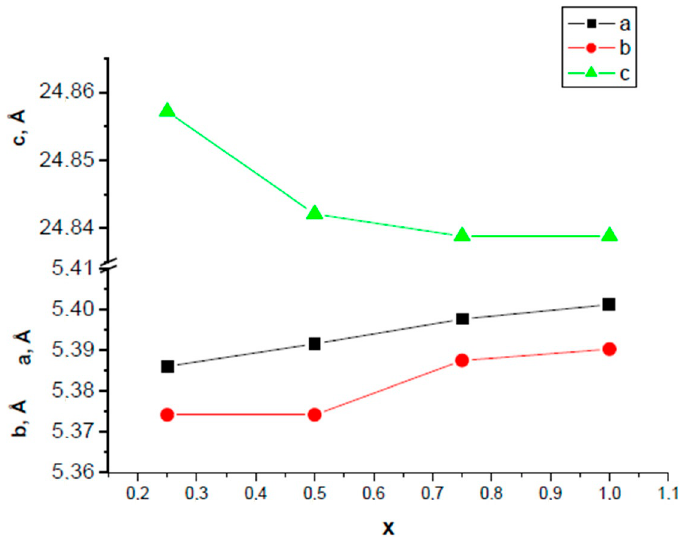
Figure 5. Dependences of the unit cell parameters a, b, c of the synthesized Bi 3 − x Nd x Ti 1.5 W 0.5 O 9 (x = 0.25, 0.5, 0.75, 1.0) on the parameter